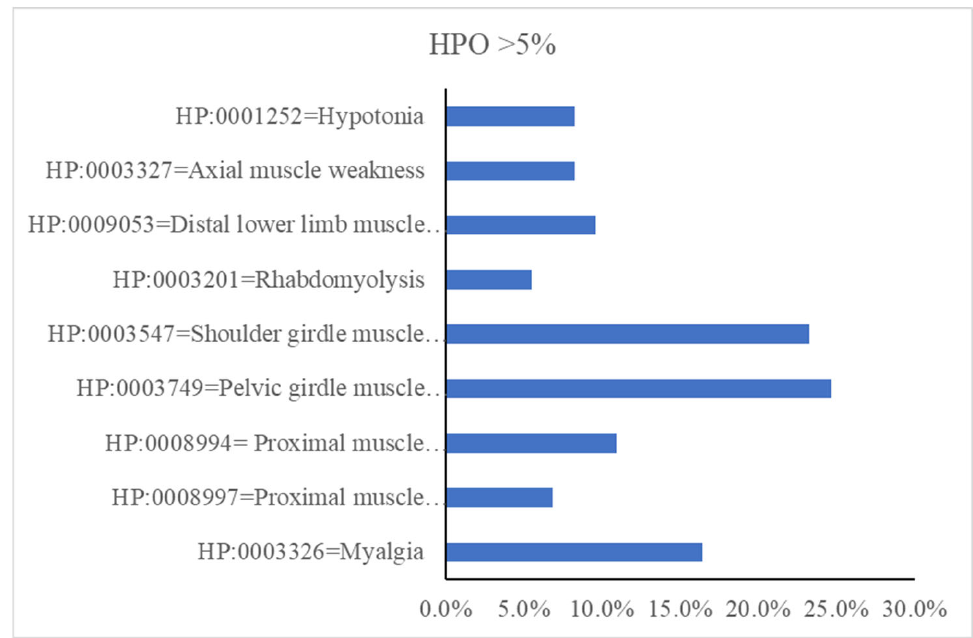
Figure 1. The most representative clinical features of symptomatic patients presented using HPO- based ID codes and nomenclature.